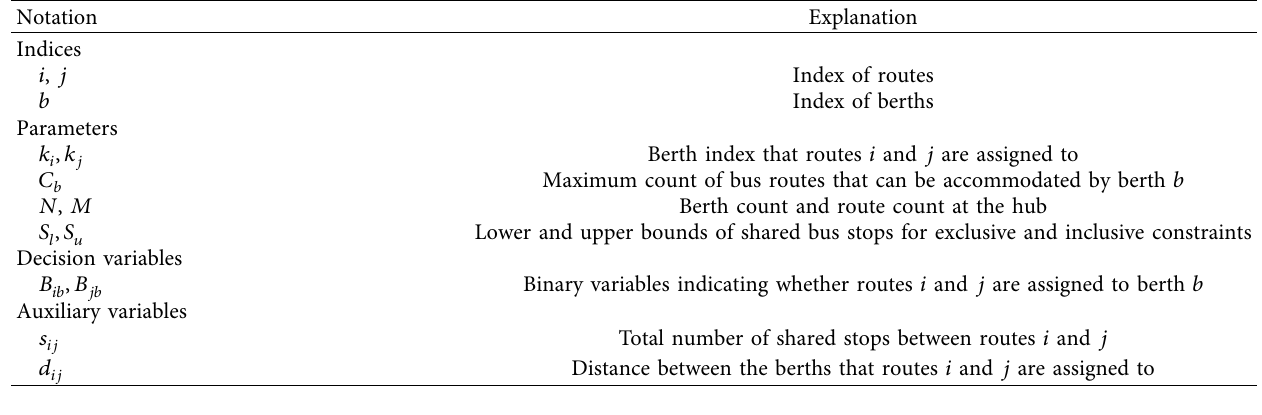
Table 1: List of